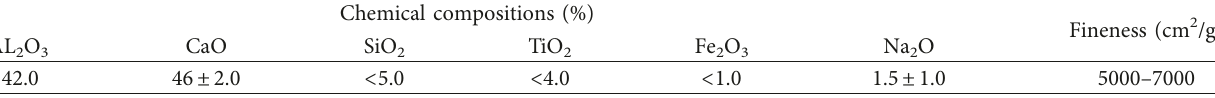
Table 1: Chemical compositions of ultra-rapid-hardening